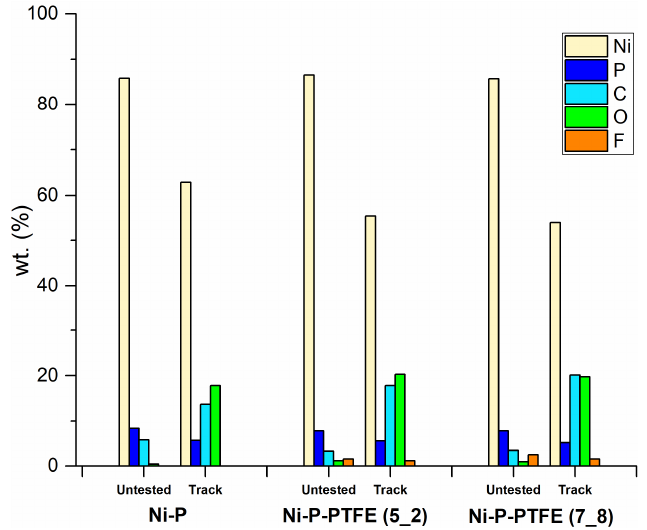
Figure 8. Elemental composition in wt. % of an untested area and wear track of Ni-P and Ni-P- PTFE films on rPDA-NBR. films on